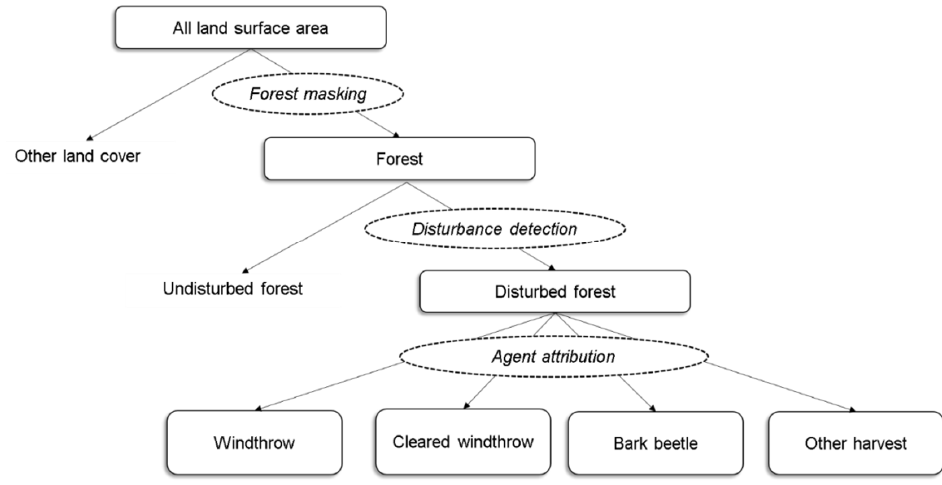
Figure 2. Workflow used for detecting and attributing forest disturbances.